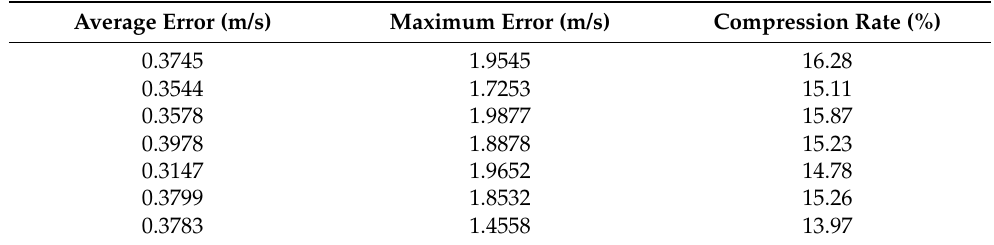
Table 2. Dictionary learning compression performance parameter under the spatial discrete